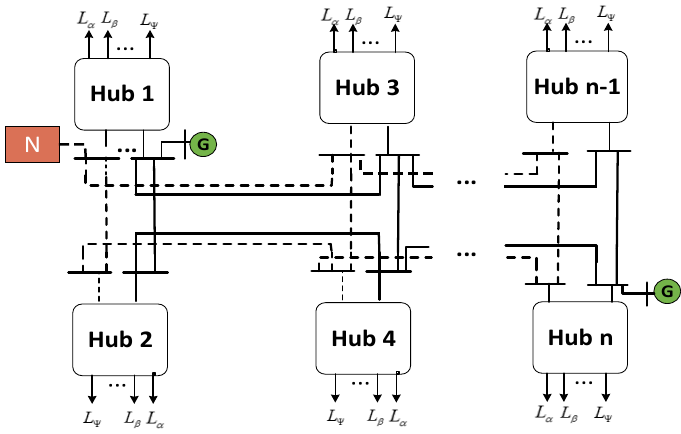
Figure 2. Energy flow interaction diagram between energy hubs.